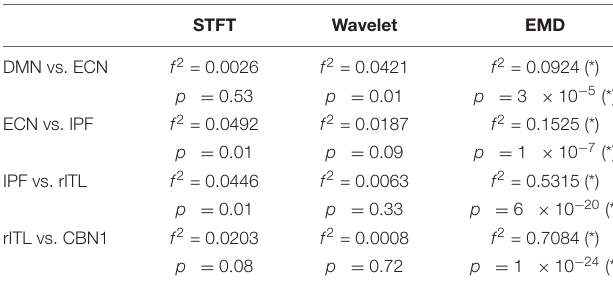
The significance that adjacent networks in Figure 7 are different was computed by an F test of a linear difference fit using logT k ( network 1 ) − logT k ( network 2 ) = k A + B + ε over all subjects, where A and B are regression coefficients and ε is an error term. Only EMD shows a very significant difference (p < 0.001) with a medium or large effect size (indicated by a star). In general, f 2 ≈ 0 . 1 2 = 0 . 01 is considered a small effect size, f 2 ≈ 0 . 25 2 = 0 . 0625 a medium effect size,